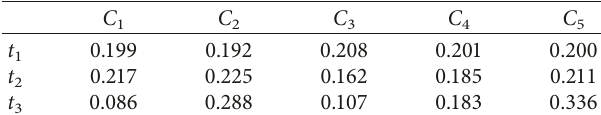
Table 5: The criteria weight.